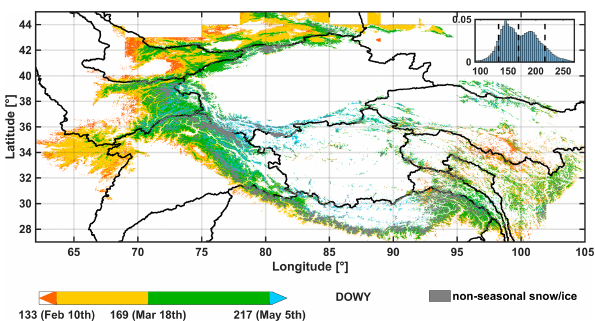
Figure 4. Map of pixel-wise peak seasonal SWE DOWY climatol- ogy, with non-seasonal snow and ice pixels masked out (gray). The inset figure is the histogram of peak SWE DOWY. The three dates labeled in the color bar (DOWY 133, DOWY 169 and DOWY 217) correspond to the 10th, 50th and 90th percentile in the DOWY dis- tribution and are marked with vertical dashed lines in the inset his-